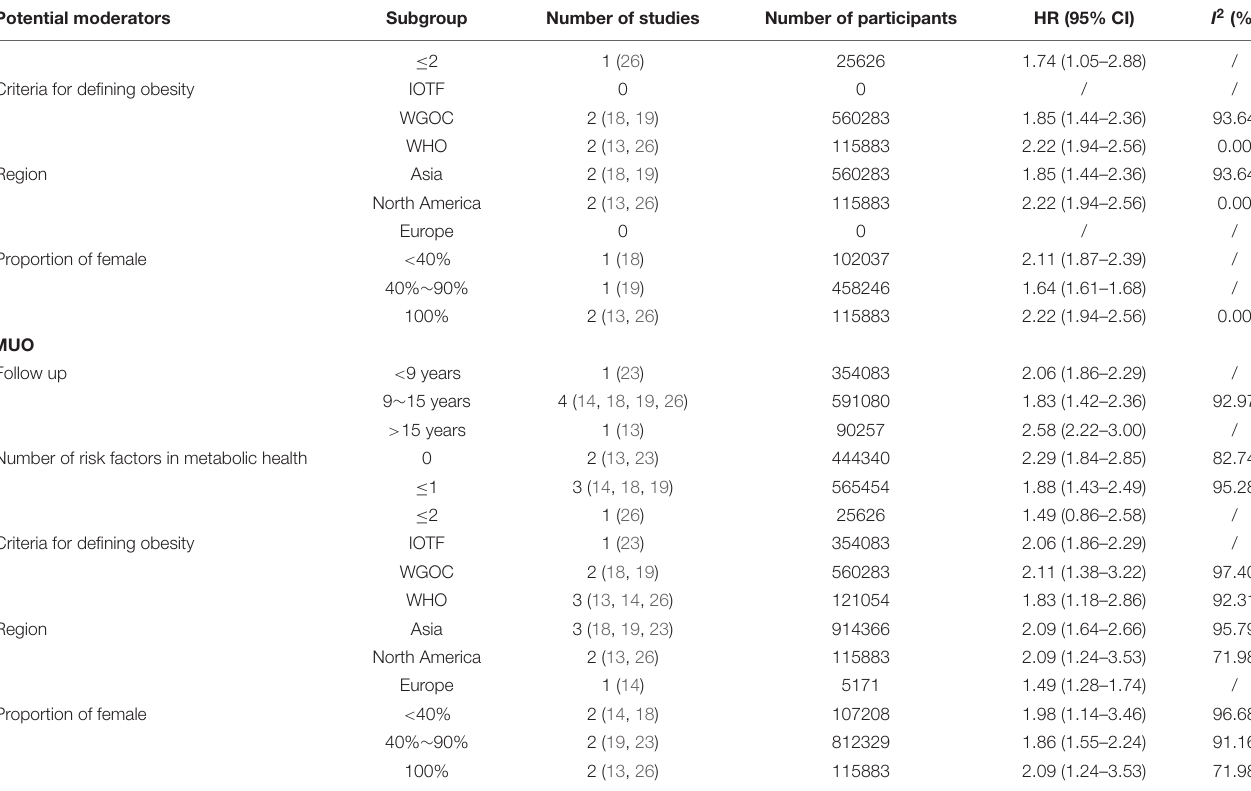
(13). The subgroup analysis also identified an associated risk of stroke for the MHO participants with obesity diagnosed based on the WHO criteria. This was not unexpected because the